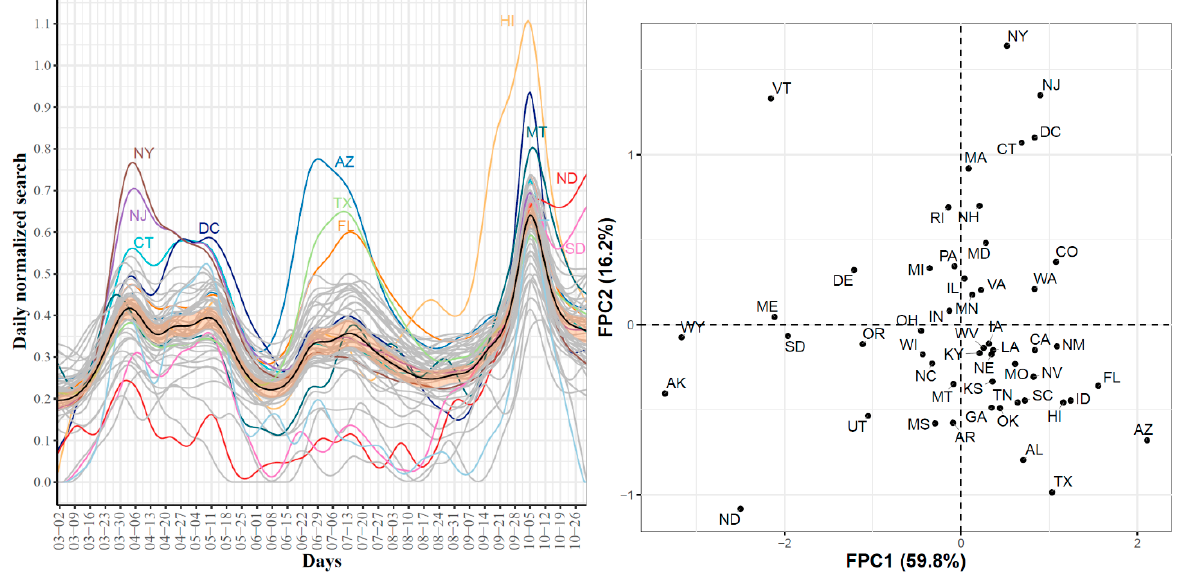
Figure 15. State-level trajectories of the Google daily searches for hypoxemia ( left ) and their projections into a two-dimensional space determined using the first two FPC scores ( right ). The mean curve is highlighted in black and the orange ribbon corresponds to the 95% confidence band.